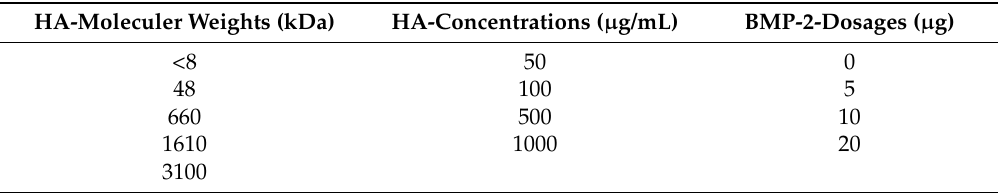
Table 1. Screening